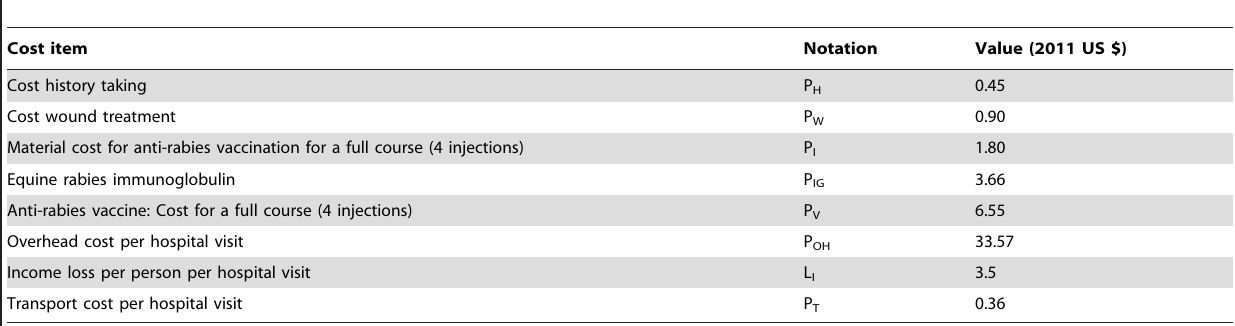
Table 2. Direct and indirect human health costs in Colombo City related to the treatment of one dog bite.